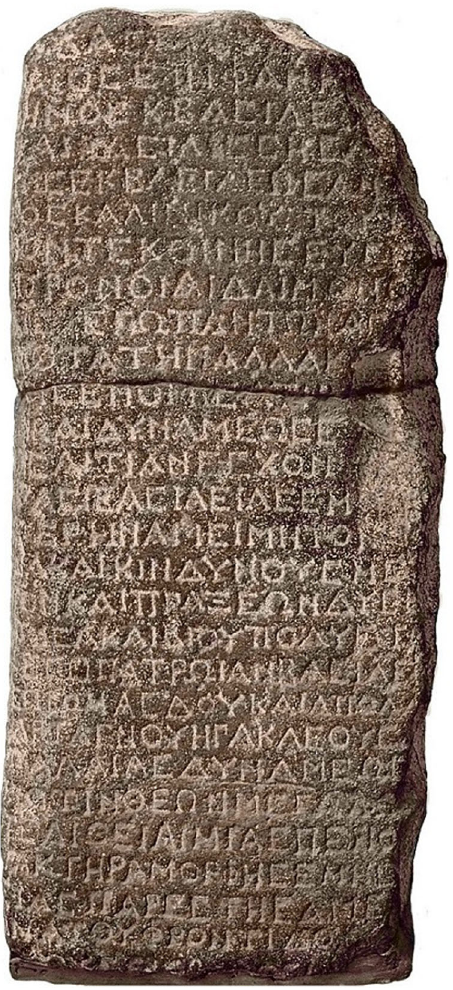
Fig. 2 Nomos. Nomos stele from Samosata, capital of Commagene.